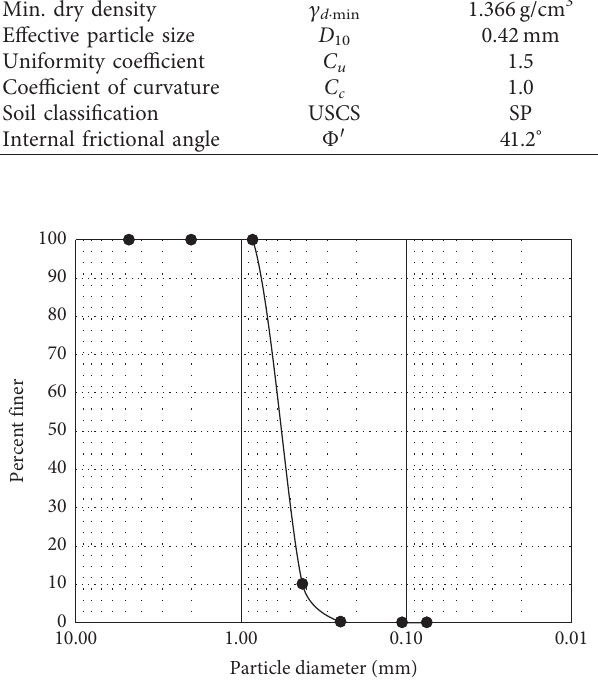
Figure 3: Grain size distribution curve of Jumunjin standard sand